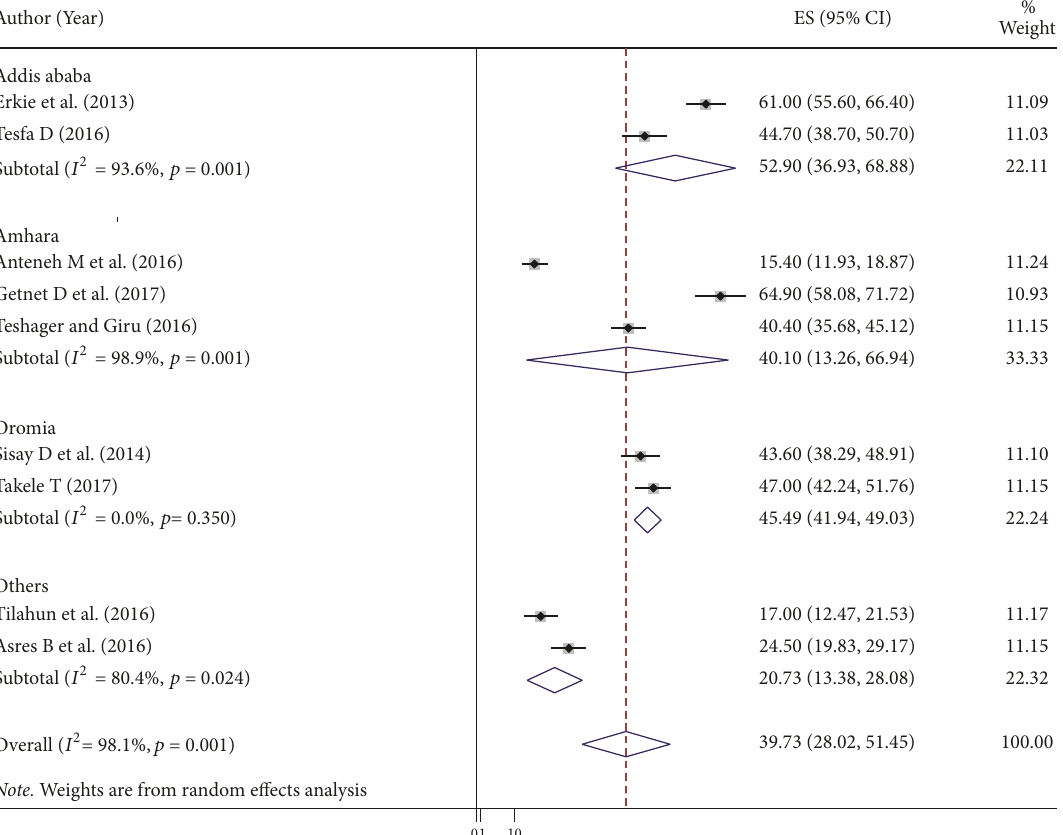
Figure 3: Subgroup analysis by regions on the prevalence of depression among diabetic patients in Ethiopia,